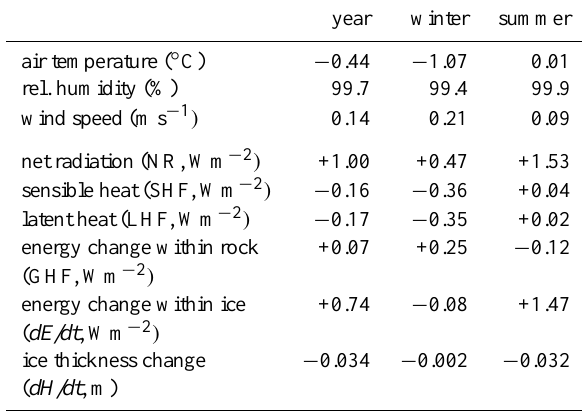
Fig. 4. Evolution of direction (upper panel) and velocitiy (lower panel) of the air flow at the measurements site. Inflow corresponds to westerly directions, outflow to easterlies.